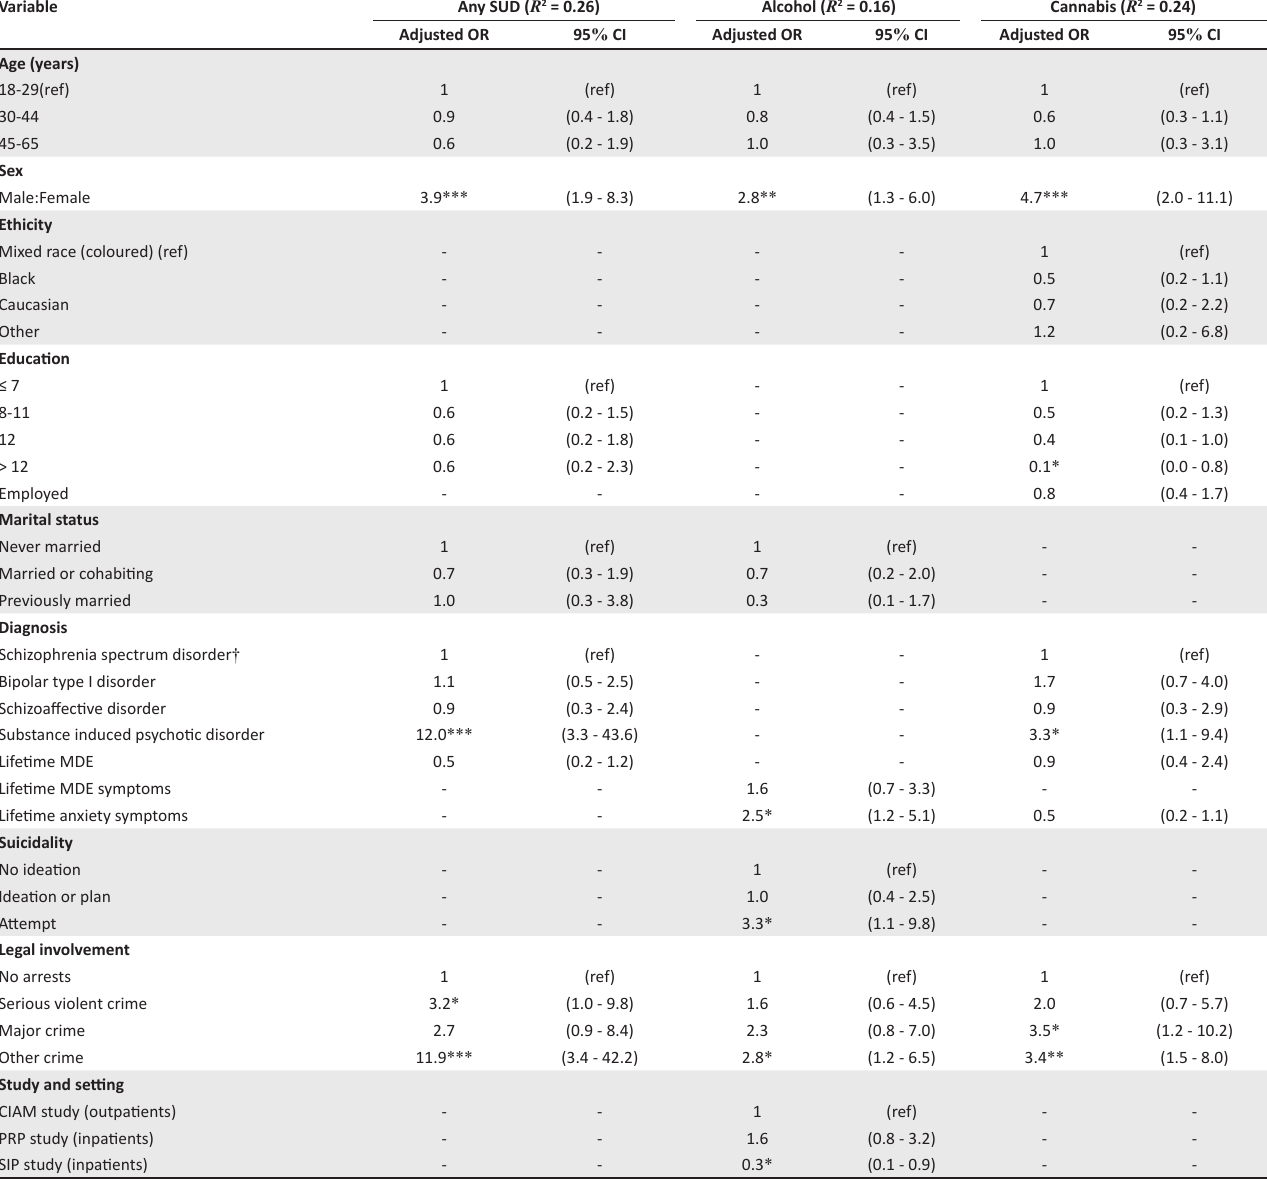
TABLE 4: Adjusted demographic and clinical association with any, alcohol and cannabis use disorders. ( N = 248). Variable Any SUD ( R 2 =